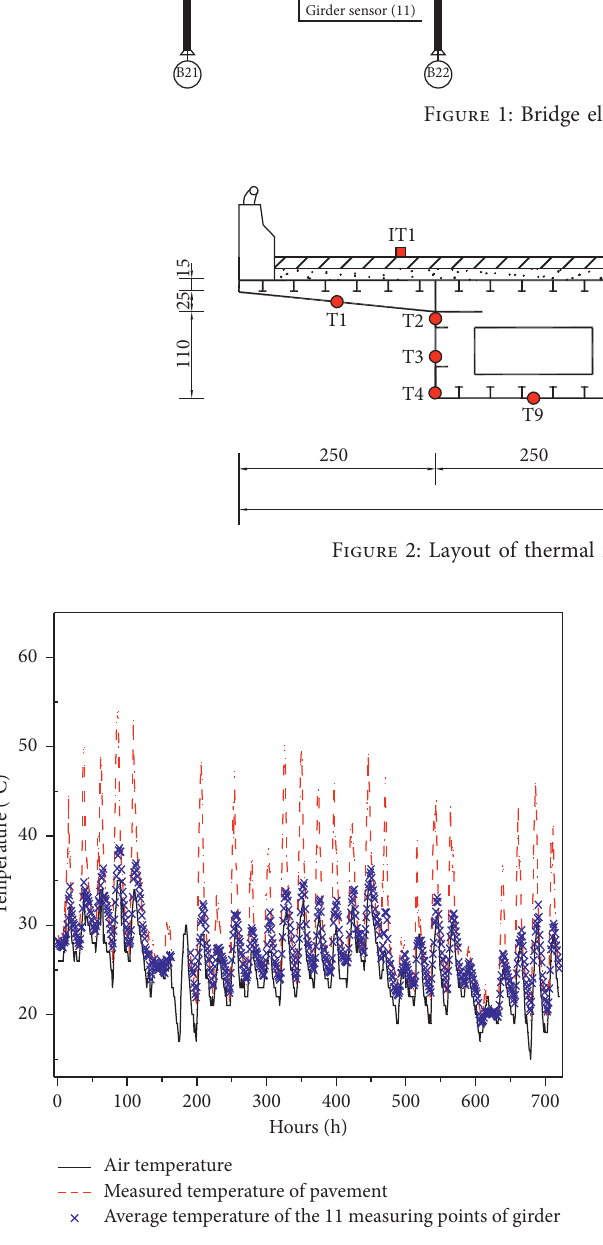
Figure 3: Comparisons of air temperature and measured tem- perature in September.